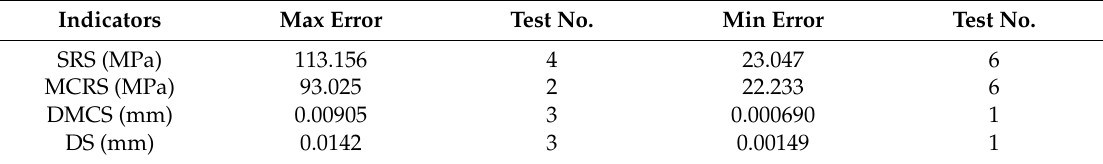
Table 8. Max and min predicted errors of residual stress